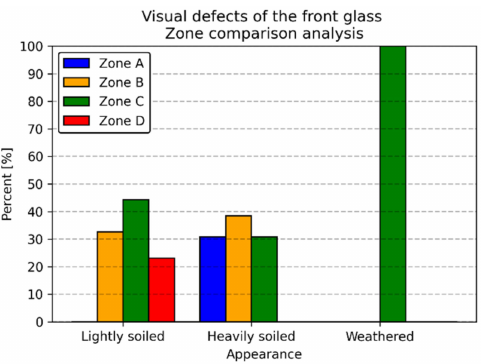
Figure 6. Zone comparison of front glass failures/defects.